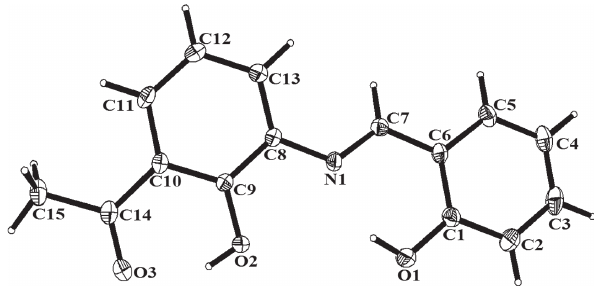
Table 1: Data collection and handling.